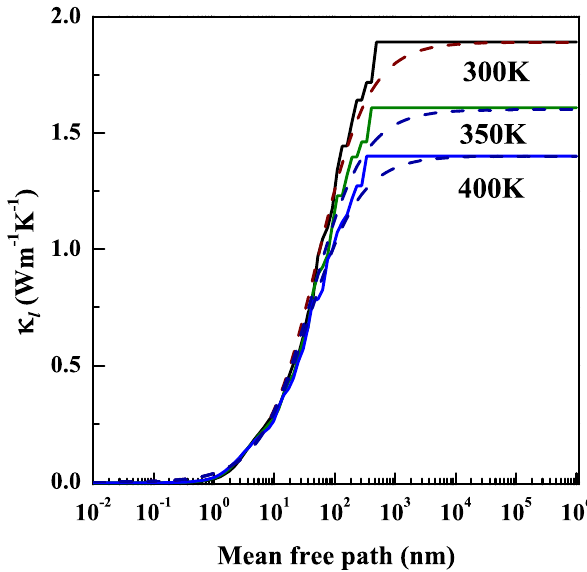
Figure 5. The obtained lattice thermal conductivities as a function of MFP at different temperatures. The fitted curves are indicated by dotted lines.